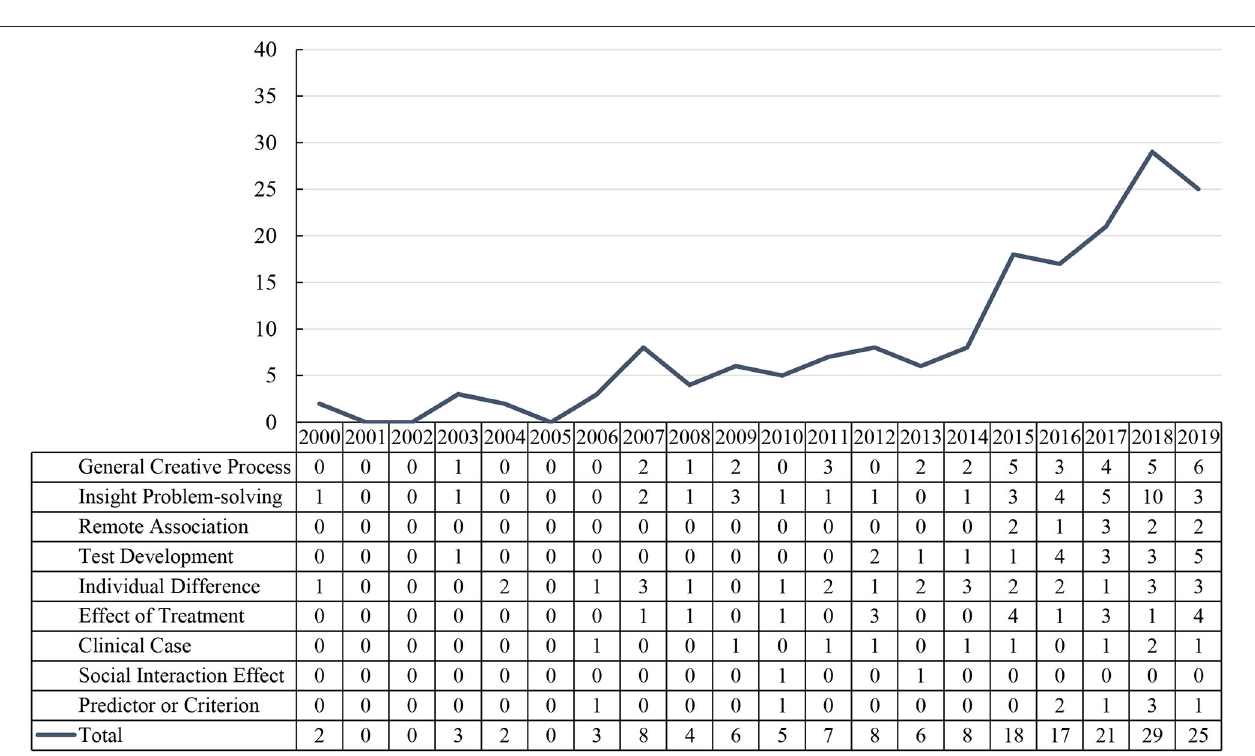
Frontiers in Psychology |